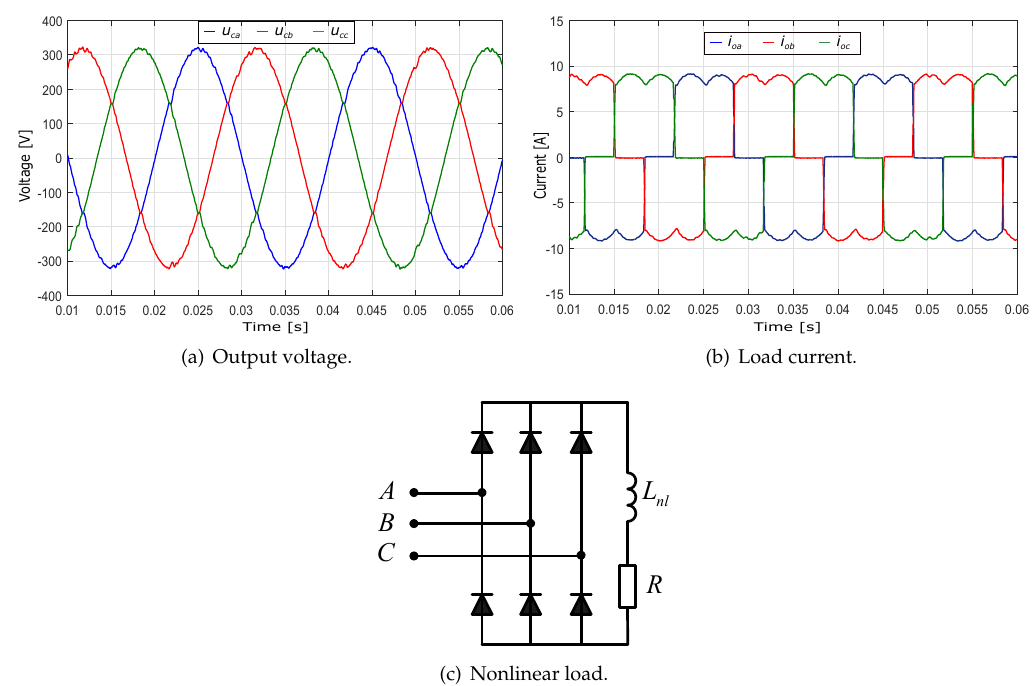
Figure 15. Output voltage and current with nonlinear load.